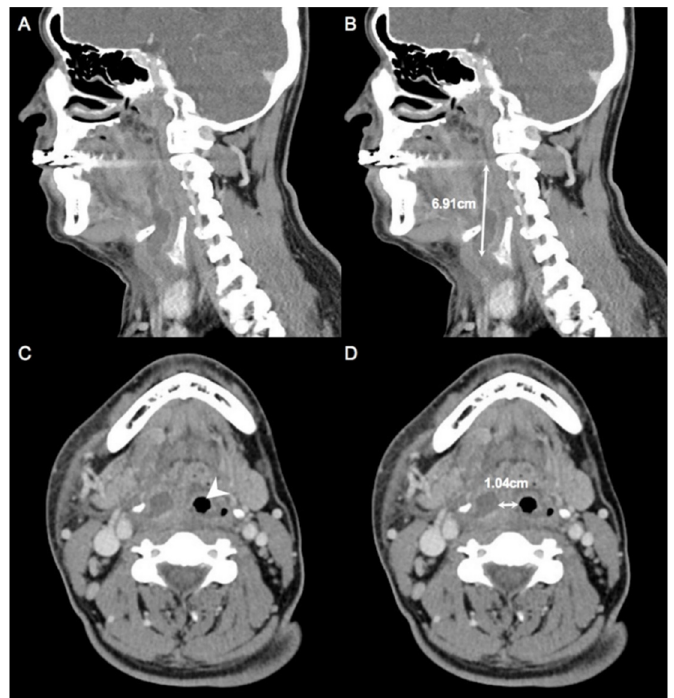
Figure 1. Parameters measured on computed tomography (CT) scans. ( A , B ) The maximum diameter of the abscess was determined based on axial, coronal, and sagittal CT scans. ( C , D ) The distance between the abscess and upper airway inlet was measured on axial scans. Arrowhead, upper airway inlet; double arrow, distance measured on CT scans.